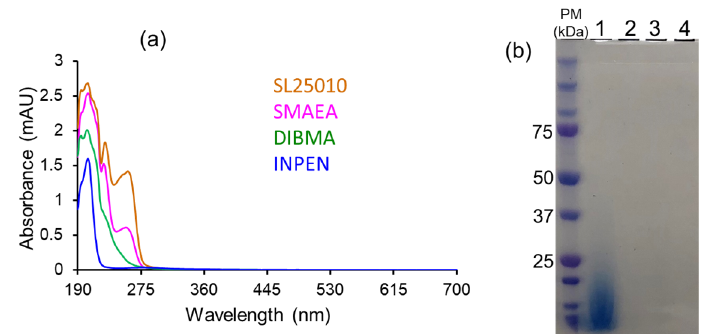
Figure 16. ( a ) UV-visible absorbance spectra of pentyl-inulin, DIBMA, SMAEA, and SL25010 poly- mers. Pentyl-inulin showed no absorbance in the 230–700 nm wavelength range. Due to aromatic rings, both SMA-based polymers SMA-EA and SL25010 showed substantial absorbance near 260 nm wavelength. ( b ) SDS-PAGE analysis of (lane-1) ~10 kDa SMA25010, (lane-2) ~2 kDa SMA-EA, (lane-3) ~12 kDa DIBMA, and (lane-4) ~3 kDa pentyl-inulin. This Figure and caption are adopted from reference [58] .